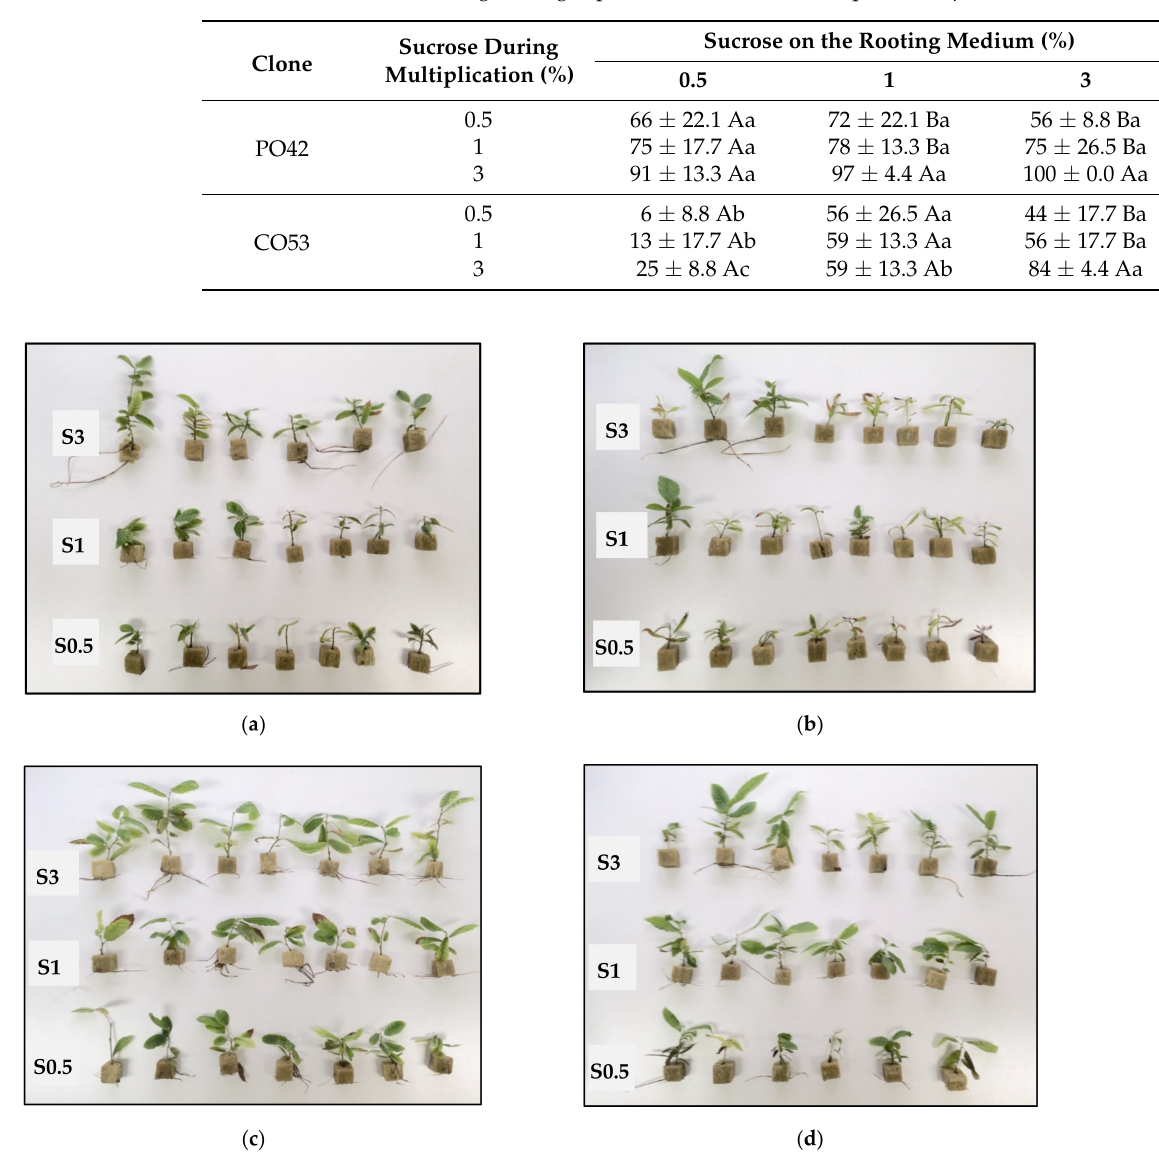
Figure 5. Chestnut shoots from clones CO53 and PO42 multiplied and rooted with different sucrose concentrations. ( a ) Shoots of CO53 cultured in sucrose 3% and rooted in sucrose 0.5, 1 and 3%. ( b ) Shoots of CO53 cultured in sucrose 0.5% and rooted in sucrose 0.5, 1 and 3%. ( c ) Shoots of PO42 cultured in sucrose 3% and rooted in sucrose 0.5, 1 and 3%. ( d ) Shoots of PO42 cultured in sucrose 0.5% and rooted in sucrose 0.5, 1 and 3%. Photos taken 5 weeks after root induction. S0.5, S1 and S3: Sucrose 0.5, 1 and